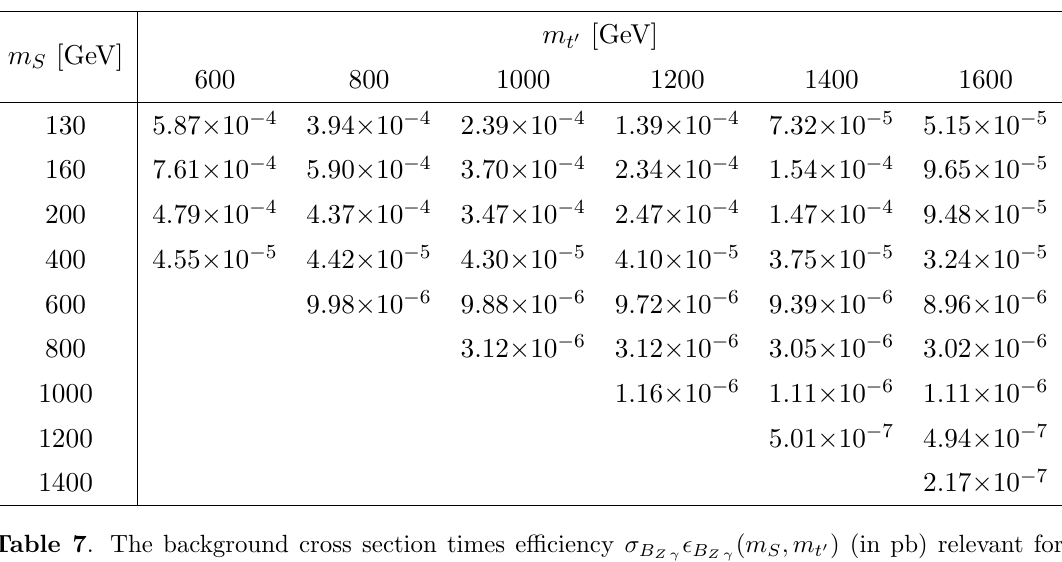
(cid:15) B ( m S ; m t 0 ) (in pb) relevant for Z (cid:13) Z (cid:13)